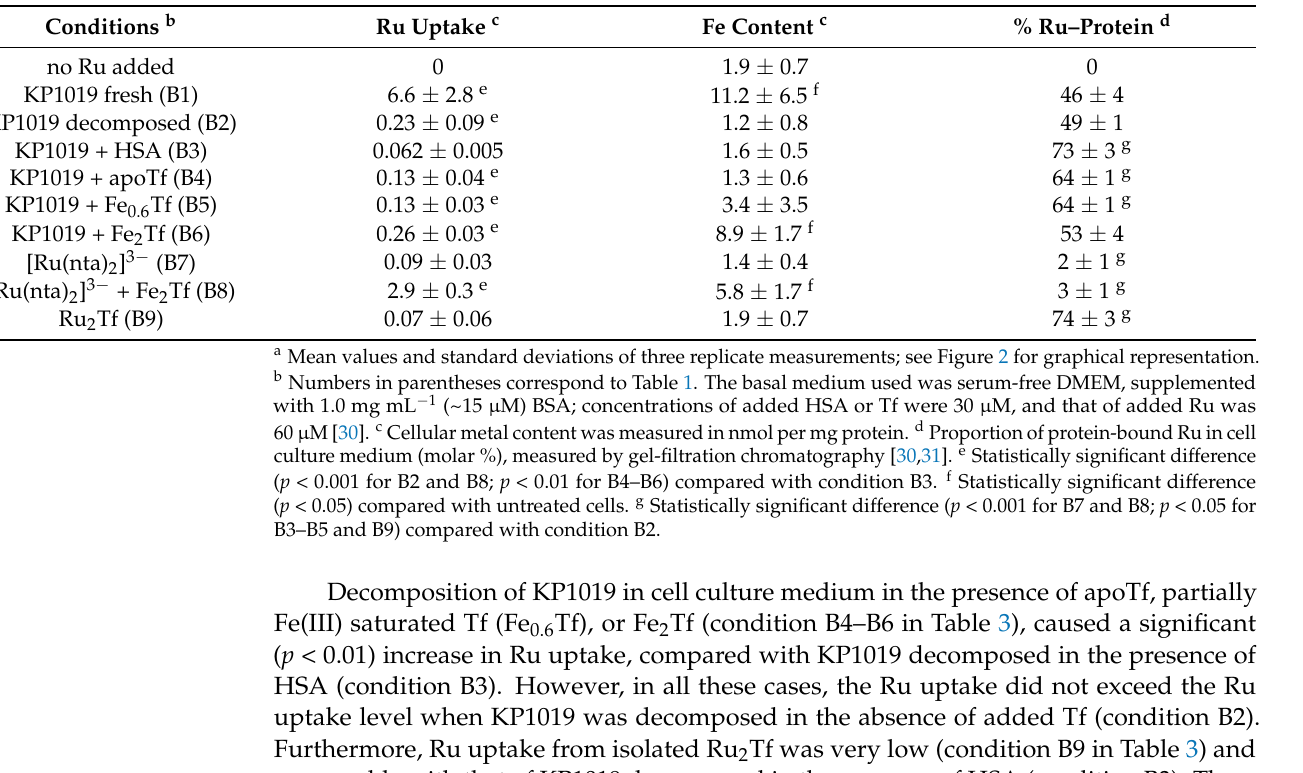
Table 3. Ru and Fe uptake by HepG2 cells and Ru–protein binding in cell culture medium in the presence or absence of Tf (24 h assays) a